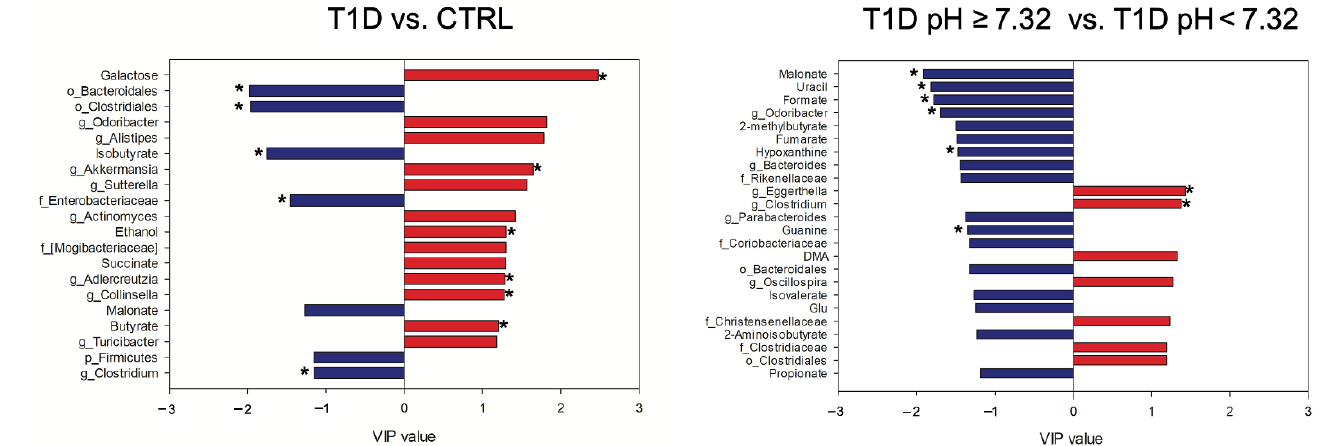
Figure 4. VIP values of the significant metabolites and bacterial taxa in the omics-data integration analysis. The levels of the features in blue are higher in T1D patients and in T1D pH ≥ 7.32, while the features in red are higher in CTRL and in T1D pH < 7.32. Features that resulted significative also at the univariate analysis were labeled with *. DMA, dimethylamine; Glu, glutamic acid.